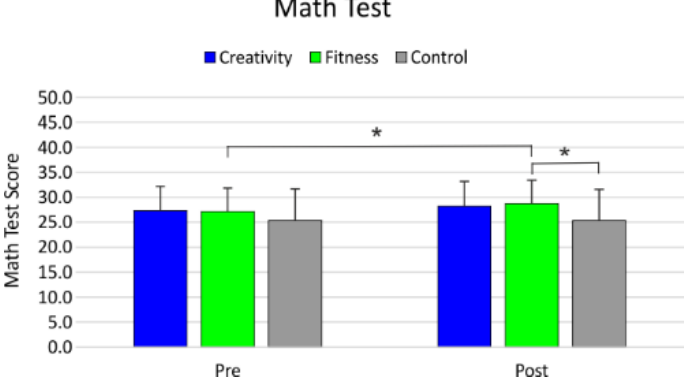
Figure 1. Math test results. * significant differences.